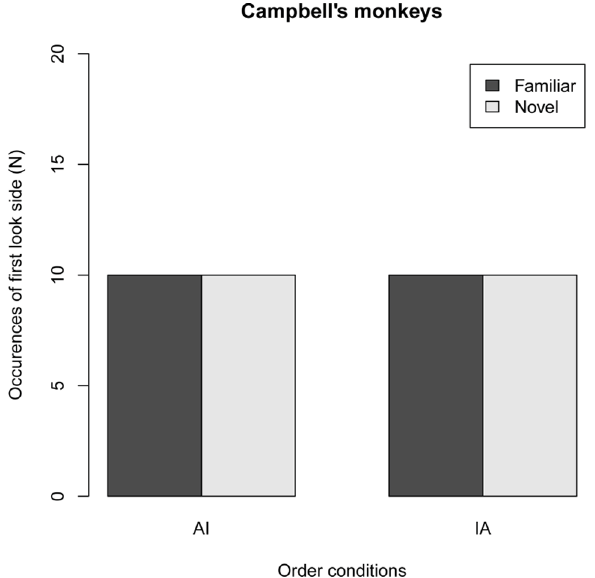
Figure 4. First look sides (FLs) for the stimulus novelty and order conditions in 40 trials of 10 Campbell ’ s monkeys. In the AI condition, the adult image was used as the stimulus in the familiar phase and the infant image served as the novel stimulus in the test phase. In the IA condition, the infant image was used as the stimulus in the familiar phase and the adult imaged served as the novel stimulus in the test phase. Black bars, FLs for familiar stimuli; white bars, FLs for novel stimuli.